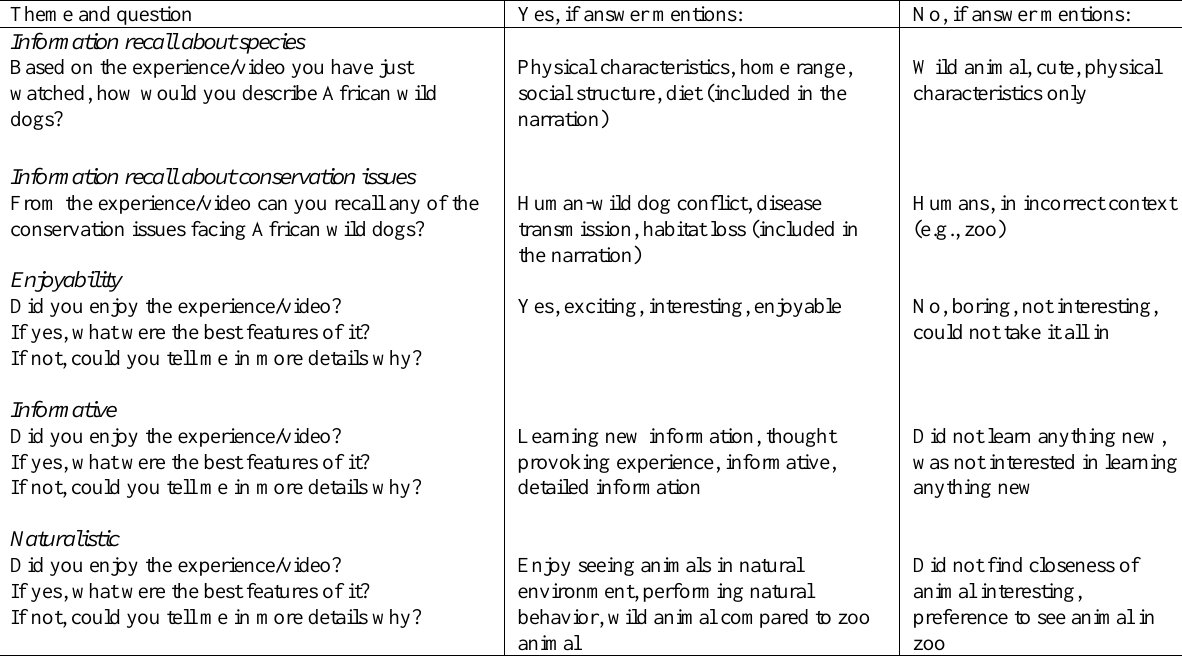
Questions and Criteria for Coding of the Qualitative